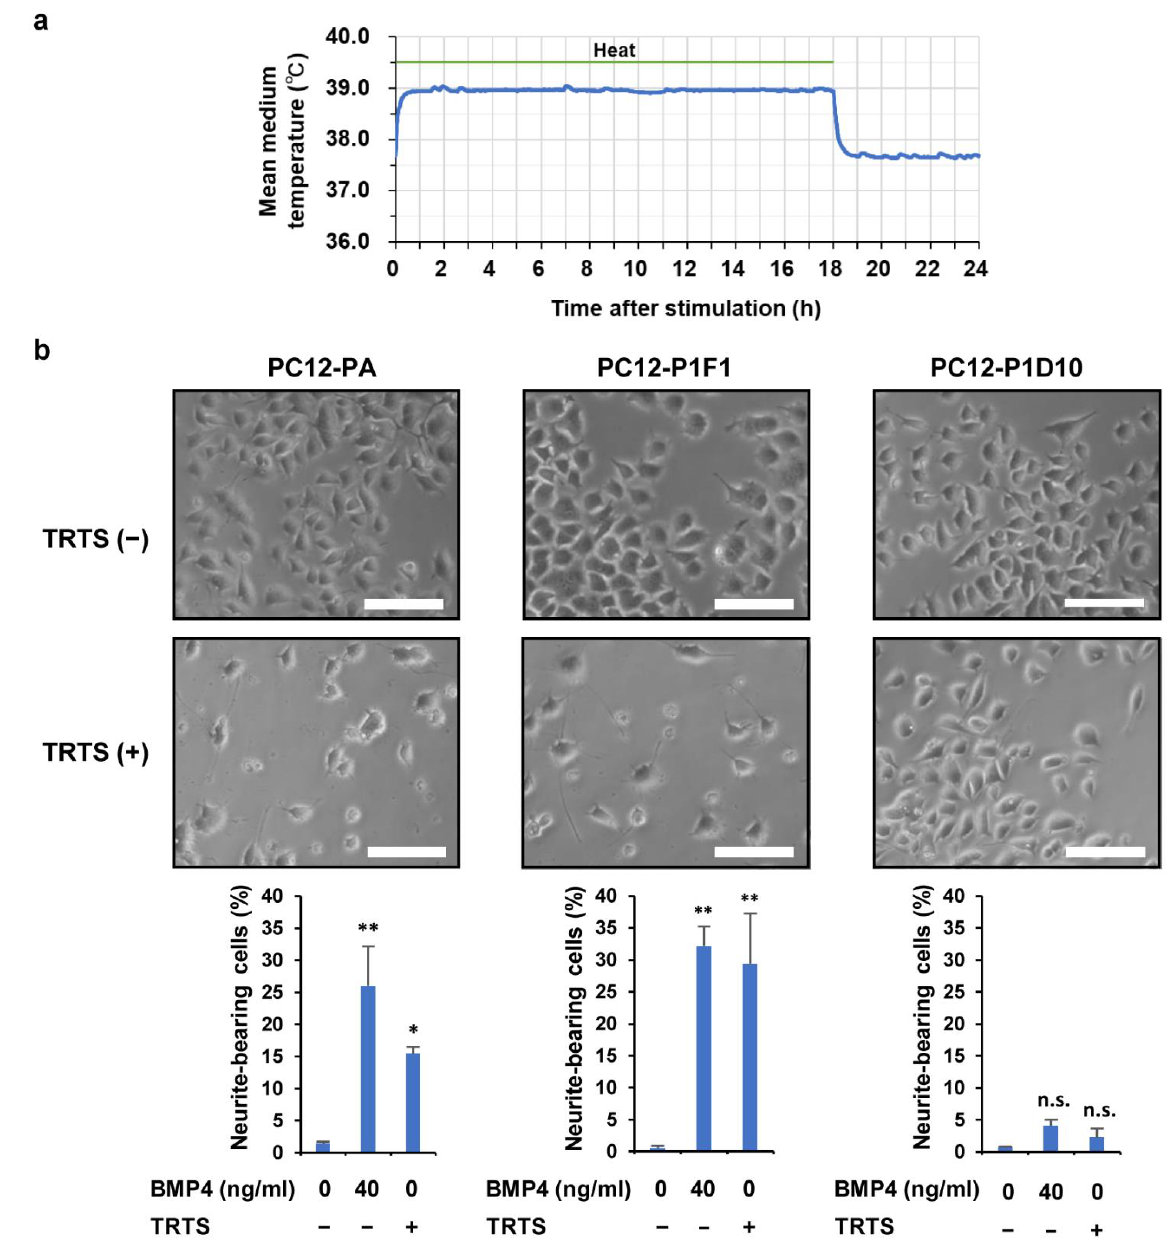
Figure 1. Comparison of temperature-controlled repeated thermal stimulation (TRTS)-induced neurite-bearing cells (%) among PC12 parental, PC12-P1F1, and PC12-P1D10 cell lines. ( a ) We evaluated temperature changes in the culture medium during TRTS. Briefly, 24 h before thermal evaluation, a cell-free culture medium was transferred into a 24-well culture plate. Then, temperatures of the culture medium during TRTS (18 h/day) were recorded every 60 s for 24 h. The data represent the average temperature changes of four independent replicates. ( b ) Cells were exposed to TRTS for 18 h per day for 7 days, and the percentage of neuritogenesis was evaluated. Representative phase-contrast micrographs of cultured cells and the data of neurite-bearing cells on day 7 with or without TRTS of three cell lines: PC12 parental cells (PC12-PA), PC12-P1F1 cells, and PC12-P1D10 cells. Scale bars: 100 μm. The data represent the means ± standard deviation of three replicates. * p < 0.05 vs. control; ** p < 0.01 vs. control; n.s., not significant vs. control.